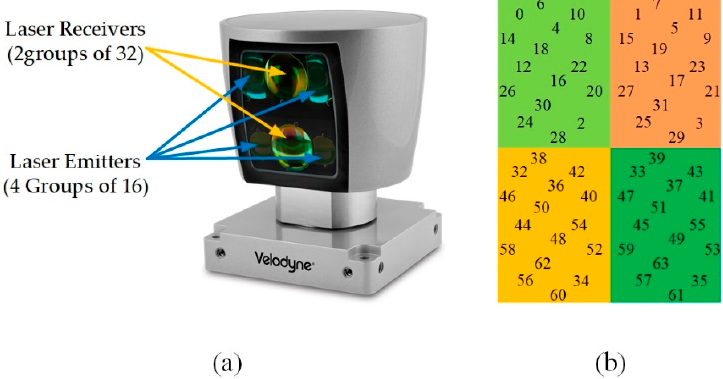
Figure 2. The multi-beam LiDAR: ( a ) Velodyne HDL-64E_S3, ( b ) distribution of 64 laser emitters.